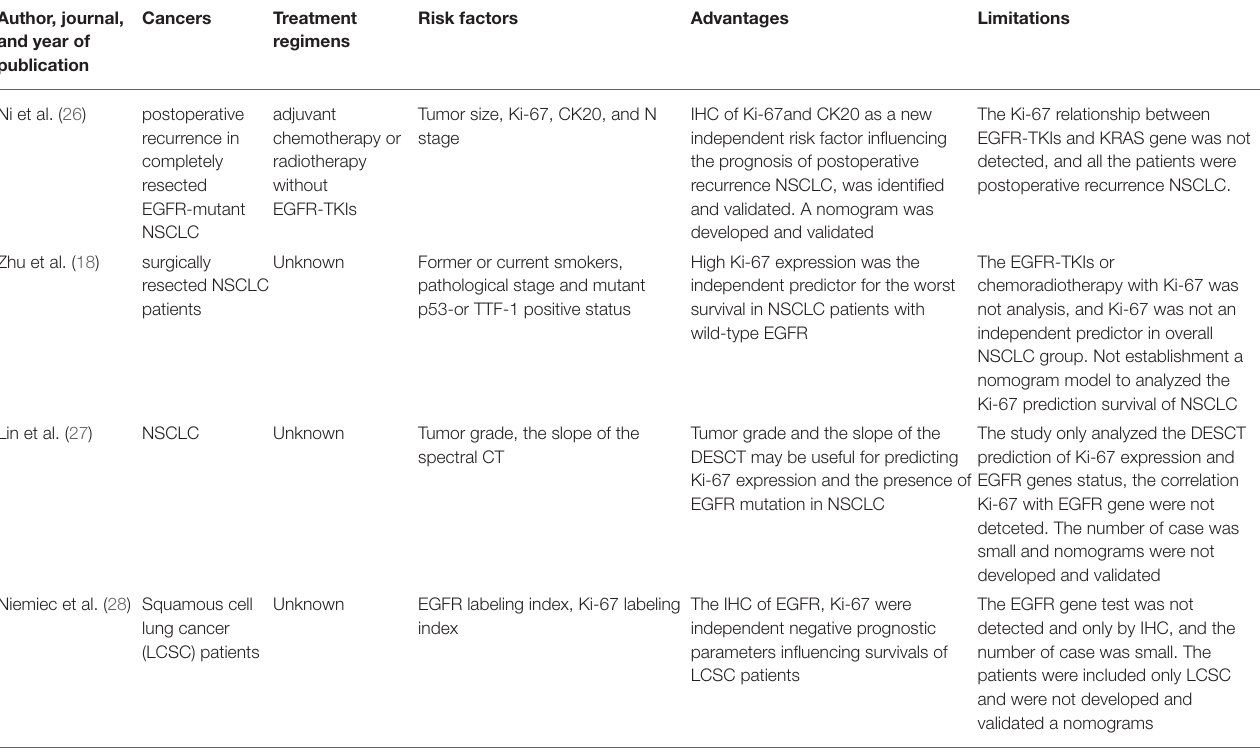
TABLE 5 | Representative studies on risk factors of Ki-67 with EGFR in